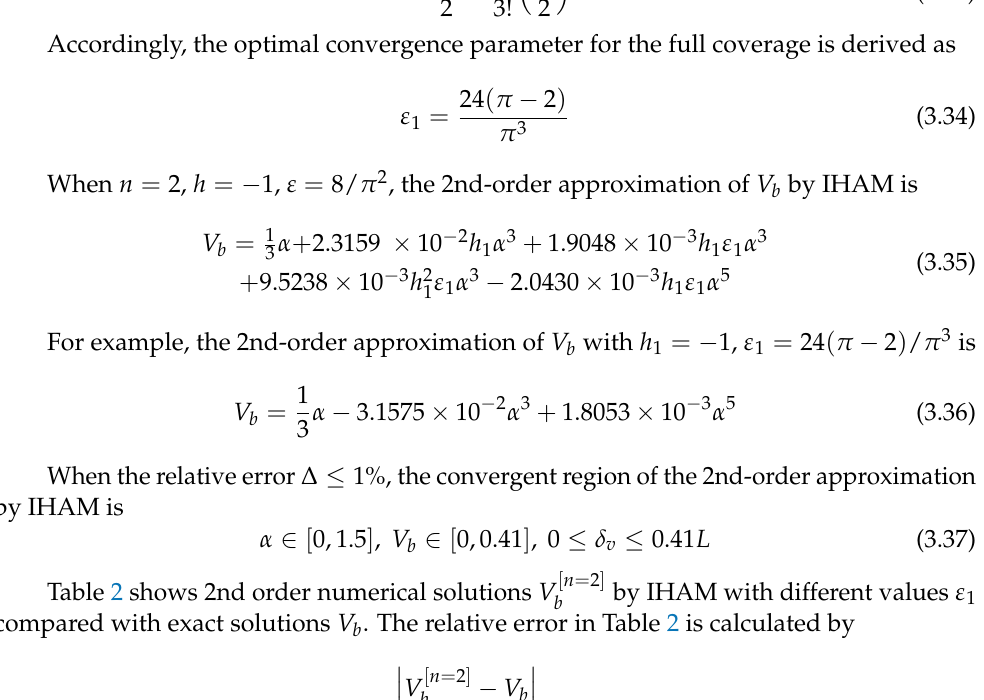
[ n = 2 ] by IHAM ( h 1 = − 1) with different values ε 1 compared b